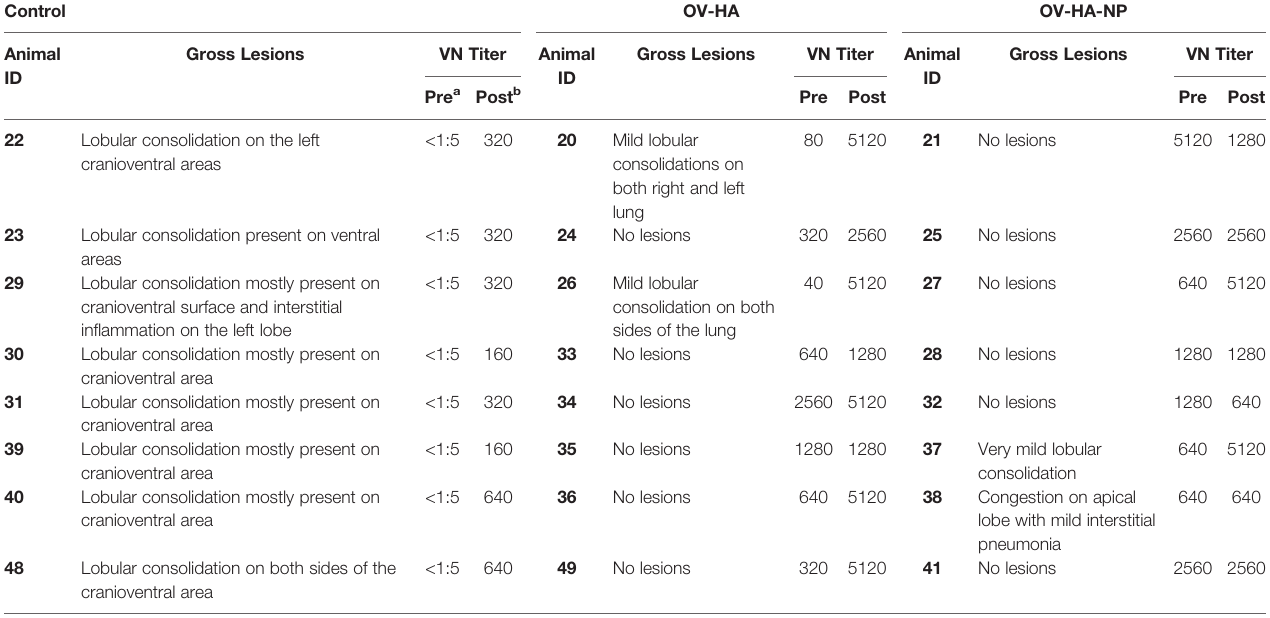
TABLE 3 | Pathological and serological fi ndings post-IAV-S-challenge in immunized pigs. Control Animal